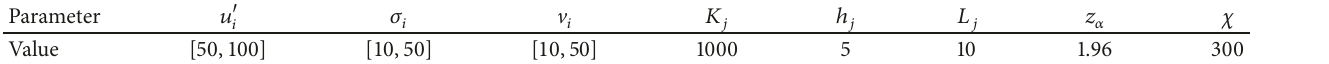
Table 1: Parameters for problem